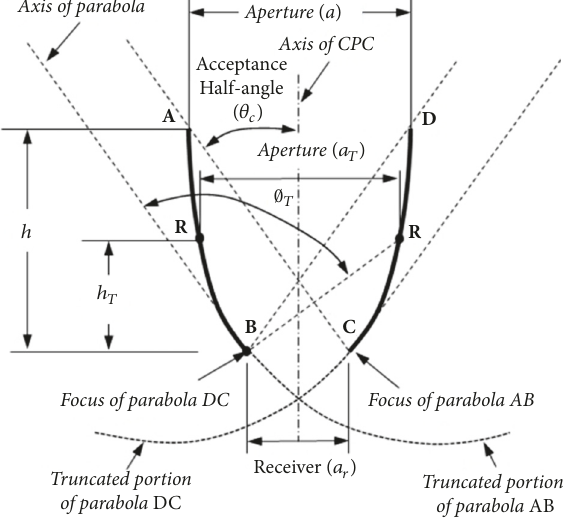
Figure 2: Cross section of compound parabolic concentrator and enlarged schematic of